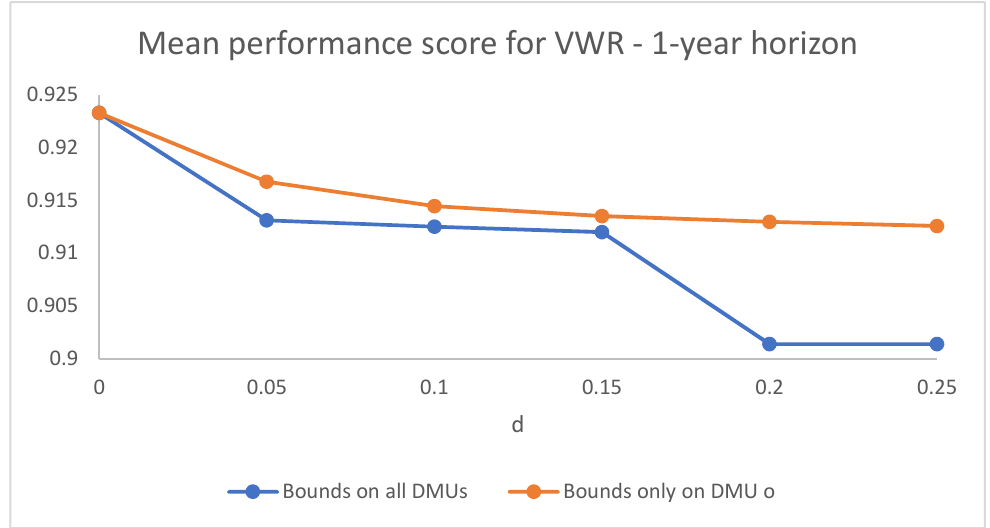
Figure 1. Comparison of the dynamics of the mean performance scores of virtual weights (VW) restrictions in the cases with constraints on all decision-making units (DMUs) and only on the target DMU as d increases, for T = 1 and symmetric